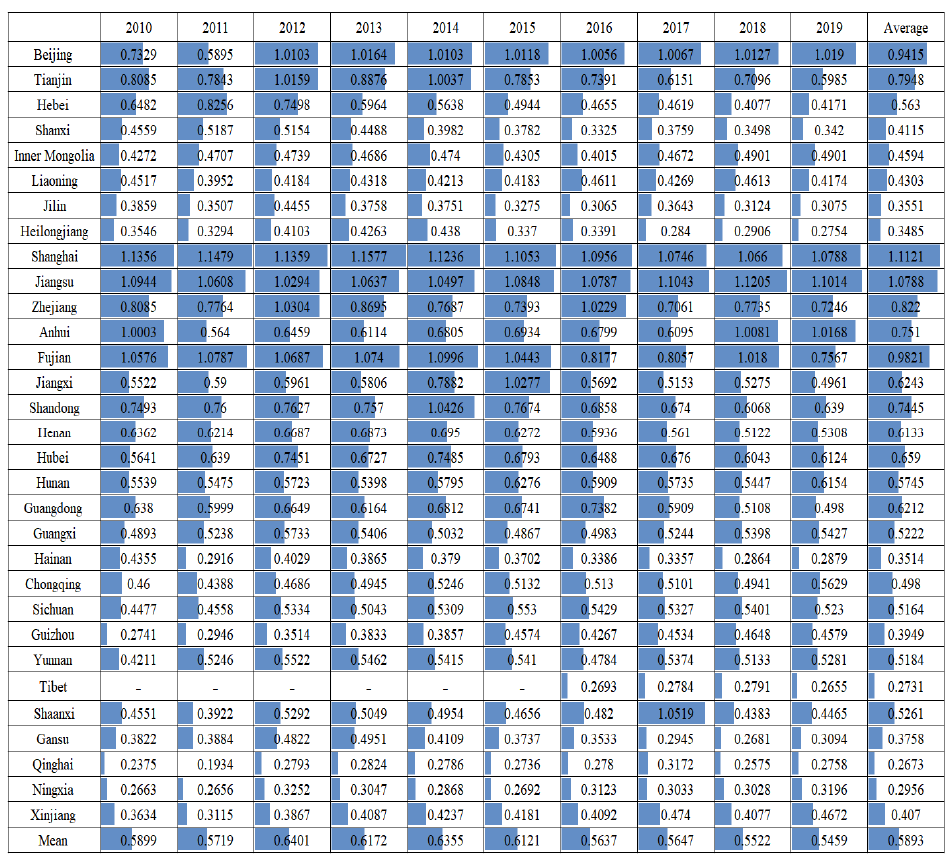
Figure 1. MSW treatment carbon emissions efficiency of 31 provinces of China during 2010–2019.